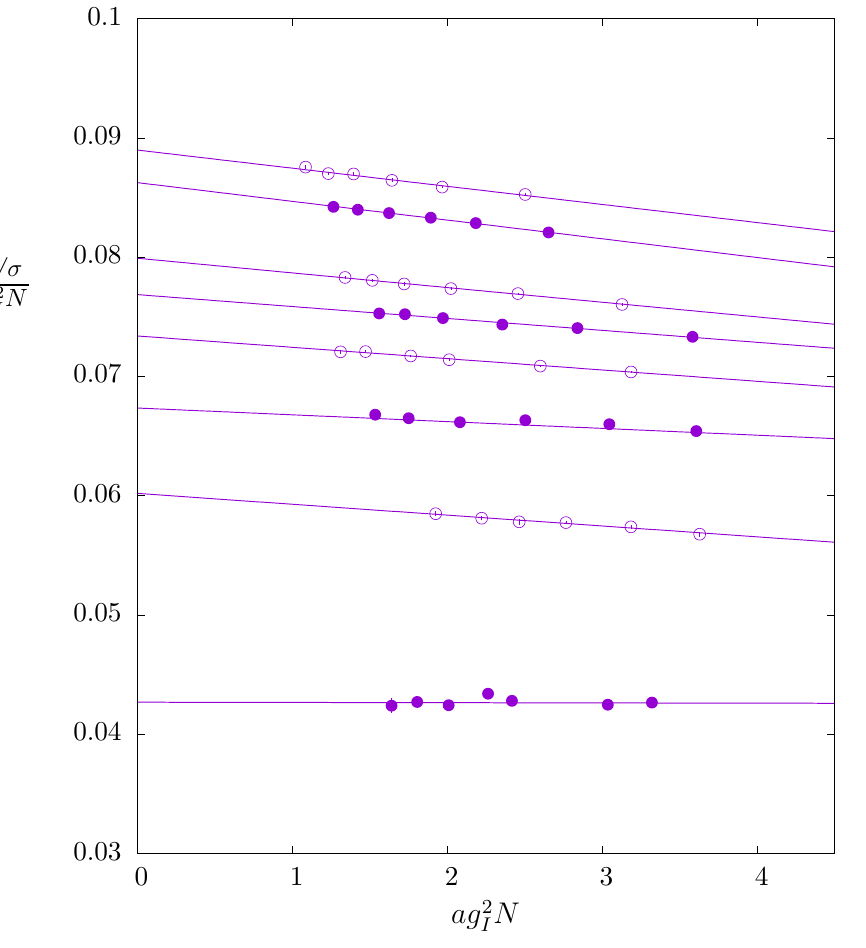
p (cid:27)=g 2 N for SO(3), SO(4), SO(5), SO(6), SO(7), SO(8), SO(12), I